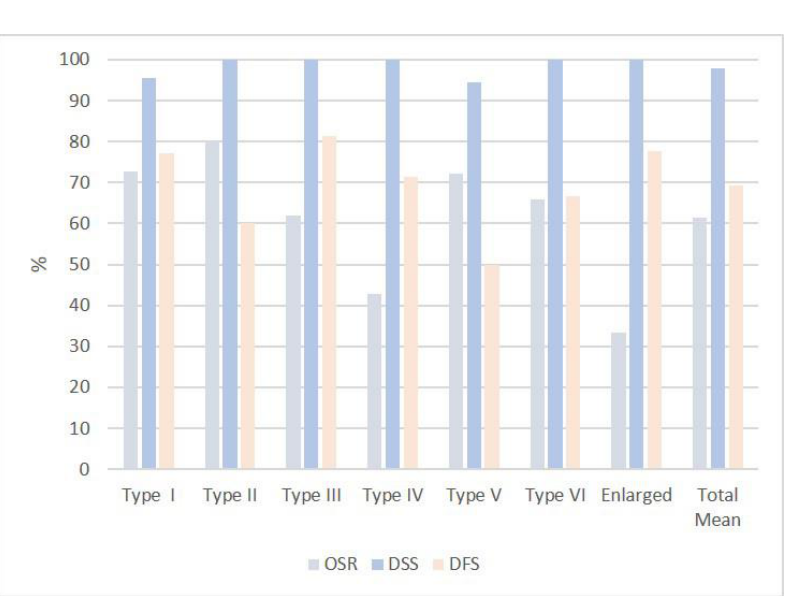
Figure 6. Graphical representation of the percentage of OSR, DSS and DFS rates in all type of cor- dectomies and enlarged procedures. cordectomies and enlarged